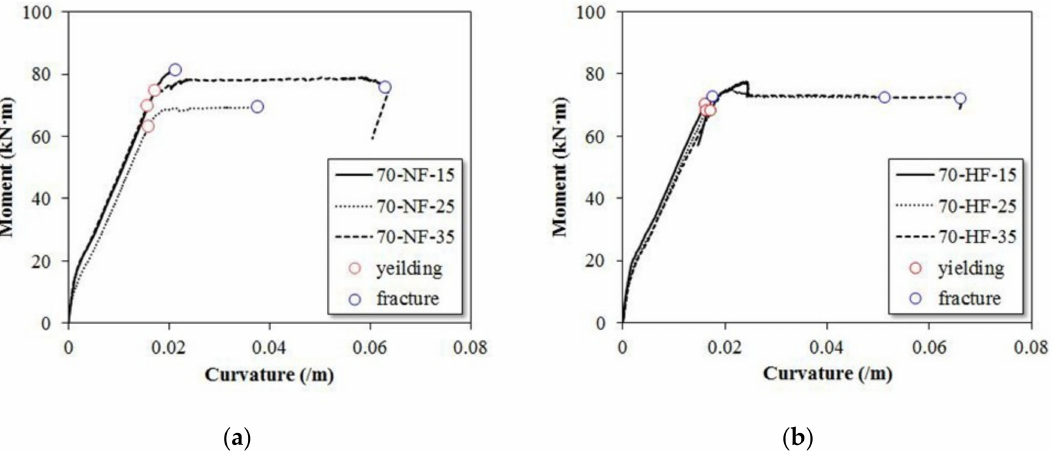
Figure 8. Effects of steel fiber tensile strength on moment–curvature relationship. ( a ) SFRC beam with normal strength steel fiber. ( b ) SFRC beam with high strength steel fiber.